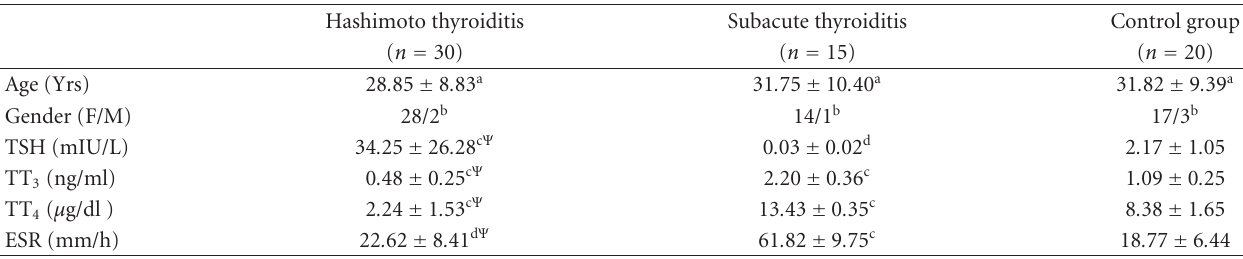
Table 1: Characteristics of HT, SAT, and Control Groups.